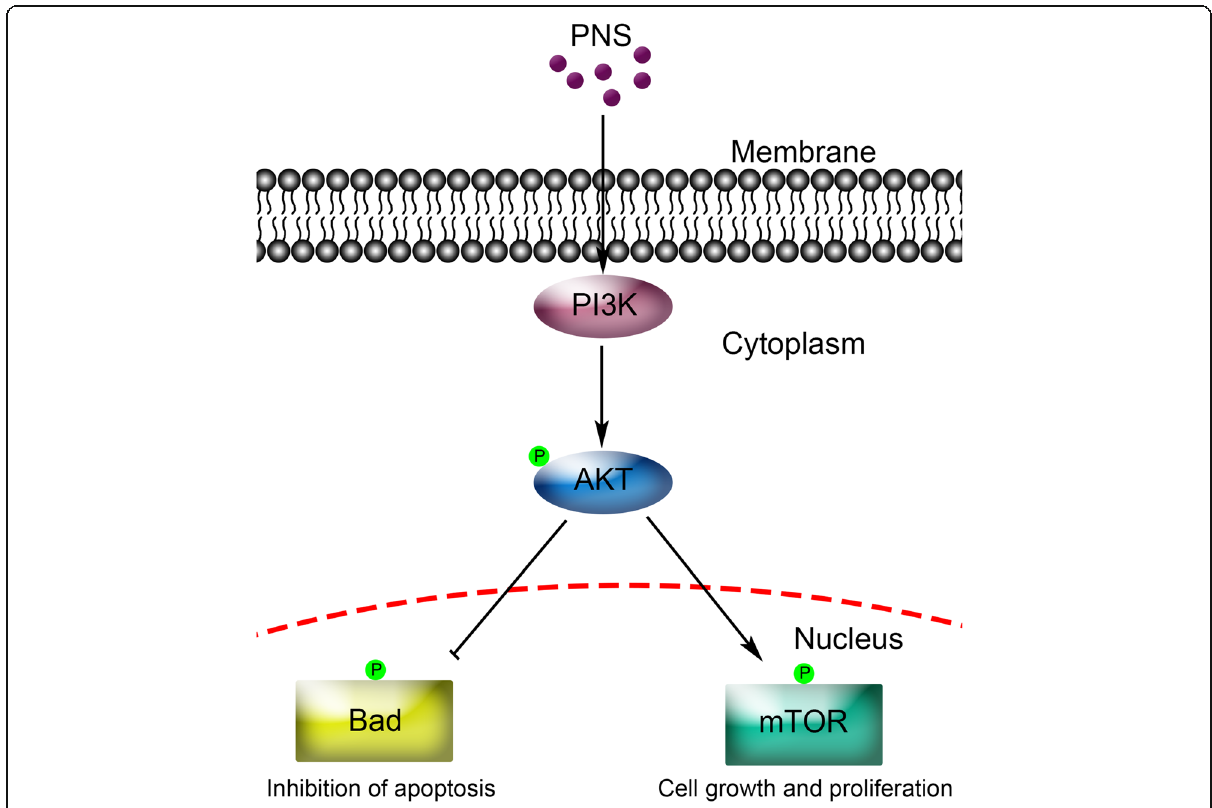
Fig. 5 A schematic model of upregulated PI3K/AKT/ mTOR cell proliferation pathway and upregulated AKT/Bad cell survival pathway by PNS in primary mouse